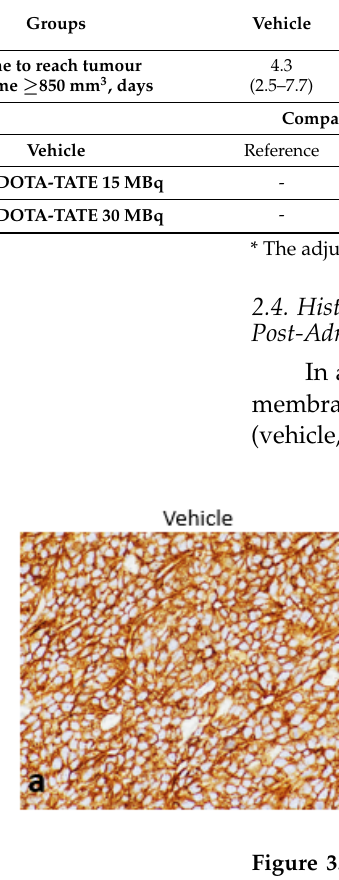
Figure 2. Anti-tumour effects of [ 177 Lu]Lu-DOTA-TATE at 15 and 30 MBq and [ 177 Lu]Lu-satoreotide tetraxetan at 15 MBq. ( a ) Tumour growth over time. Data are mean ± standard error of the mean. ( b ) Kaplan-Meier curves of Time to Reach Volume of 850 mm 3 (TTRV850). Table 2. Median tumour growth delay (95% confidence interval).